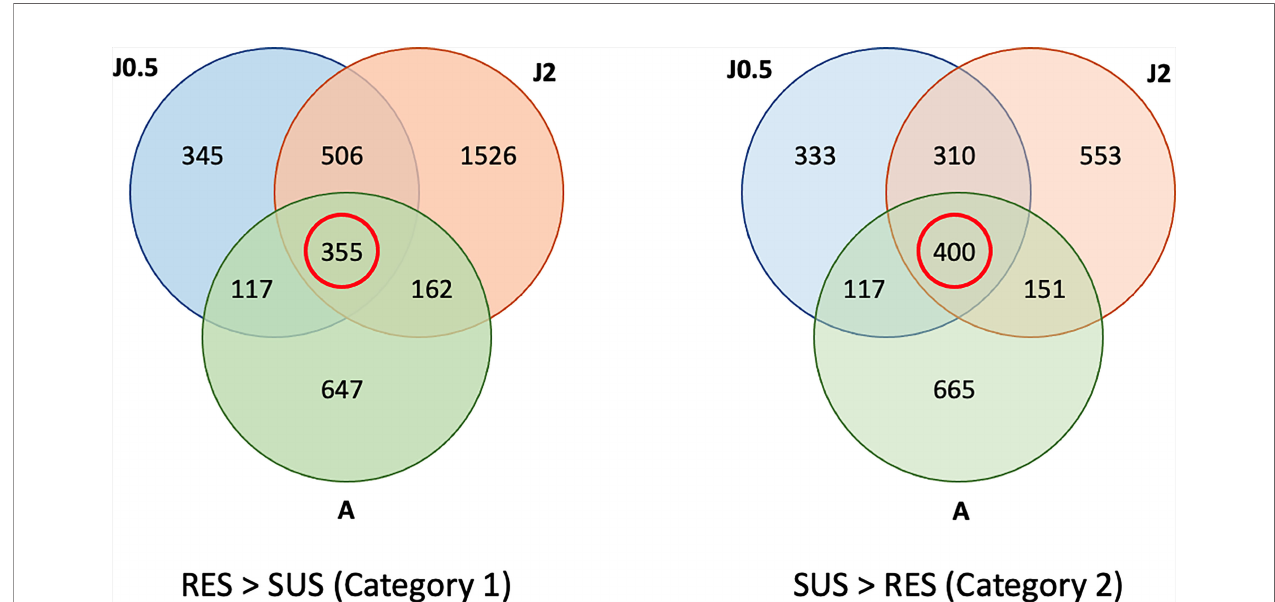
FIGURE 4 | Venn diagrams showing numbers of genes in common among three comparisons of unexposed control RES and SUS snails. Contents outside of each circle refer to the speci fi c sampling time points indicated in Table S2 (RES vs. SUS). The three comparisons include RES vs. SUS with juvenile controls @0.5 dpe (J0.5), @2 dpe (J2), and with adult controls @40 dpe (A). The red circle shows the genes in common in all 3 comparisons, with gene transcript representation greater in RES > SUS (Category 1), or SUS > RES (Category 2). Genes in common to all three comparisons (within the red circles) were subject to further